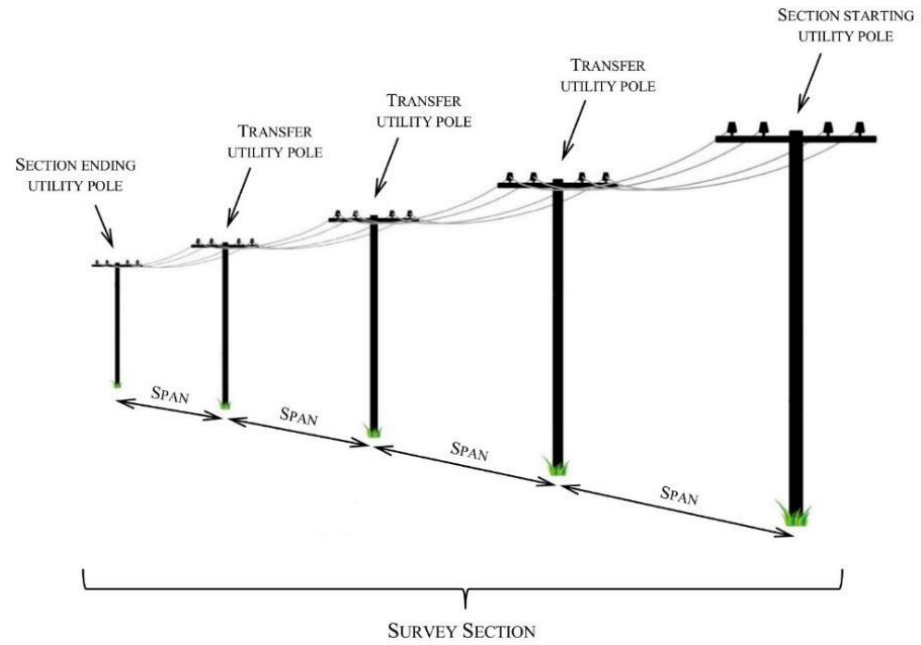
Figure 5. Sketch of basic elements of a survey section.